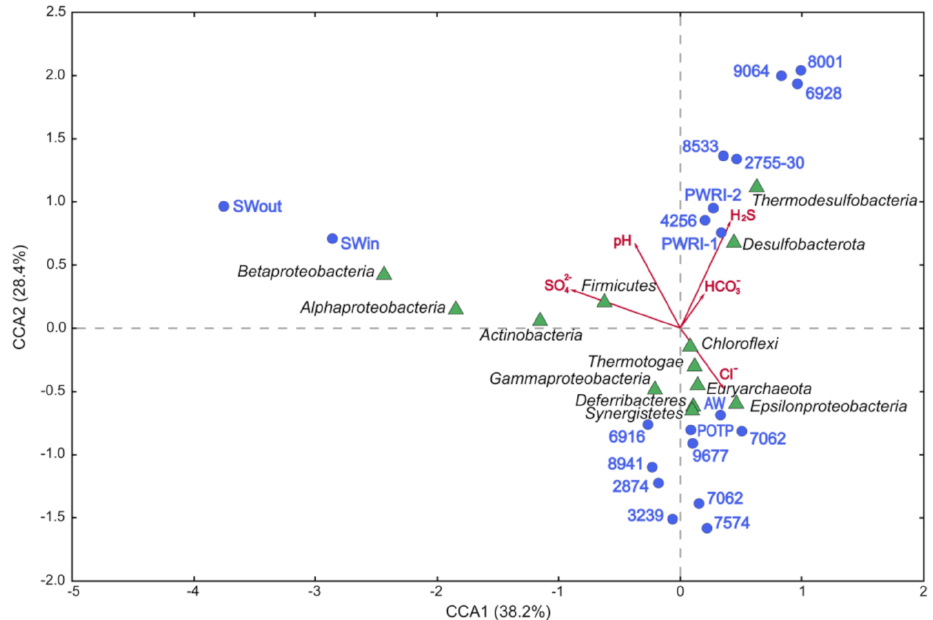
Figure 3. Canonical correlation analysis showing the correlation between the geochemical parameters and prokaryotic diversity at the phylum (class) level in the 16S rRNA gene libraries from microbial communities of seawater and formation water from the Uzen oil